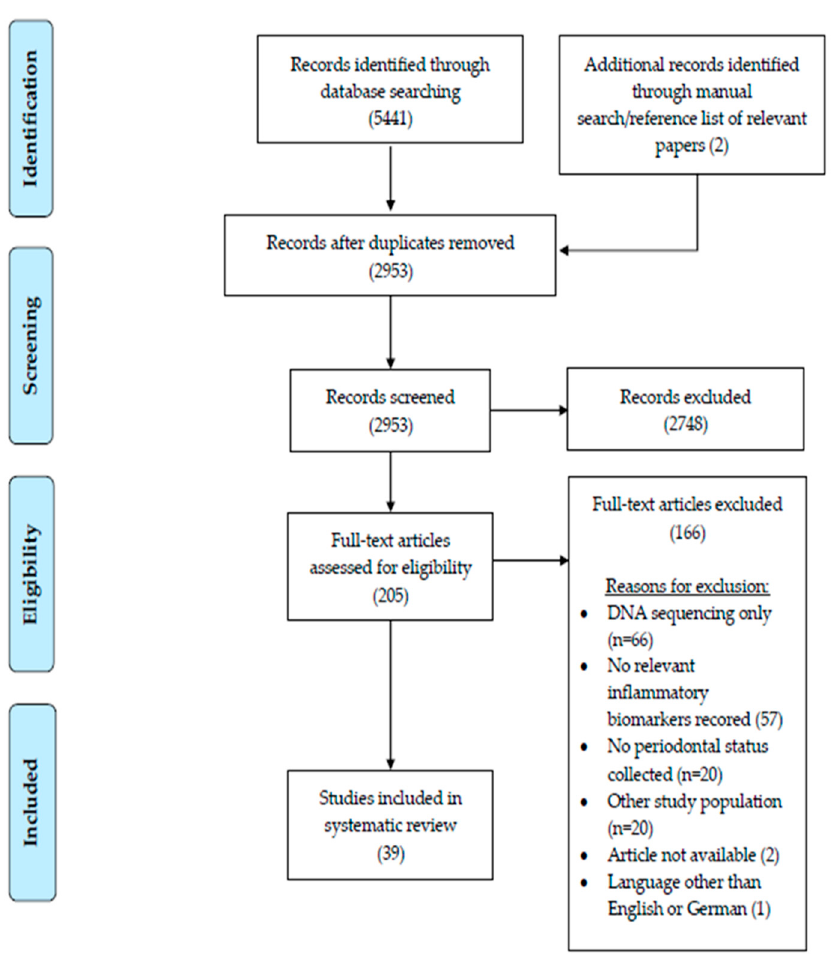
Figure 2. Flow diagram of study identification.